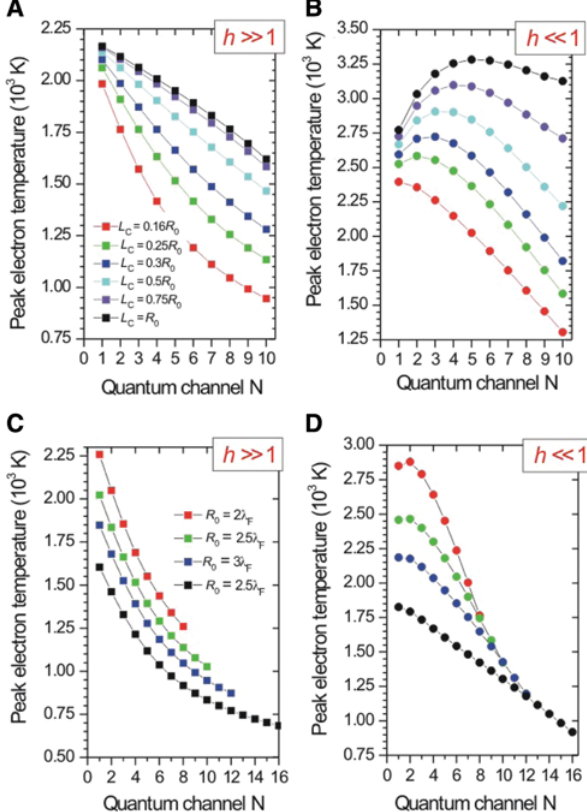
Figure 5: Peak electron temperature versus the number of open quantum channels N in the contact calculated in (A) and (B) at a = 2.5 λ fixed radius R , and in (C) and (D) at a fixed cylinder length 0 F = λ L /2. c F Squares represent data at large parameter h  1, while circles correspond to h  1. In (A) and (B), data are plotted for different = R = R lengths of the interconnection region: L /6 (red), L /4 c 0 c 0 = R = R = 3 R = R (green), L /3 (blue), L /2 (cyan), L /4 (violet), and L c 0 c 0 c 0 c 0 (black). In (C) and (D), the data are plotted for different radii of the = 2 λ = 2.5 λ cylinder interconnection region: R (red), R (green), 0 F 0 F = 3 λ = 4 λ R (blue), and R 0 F 0 F